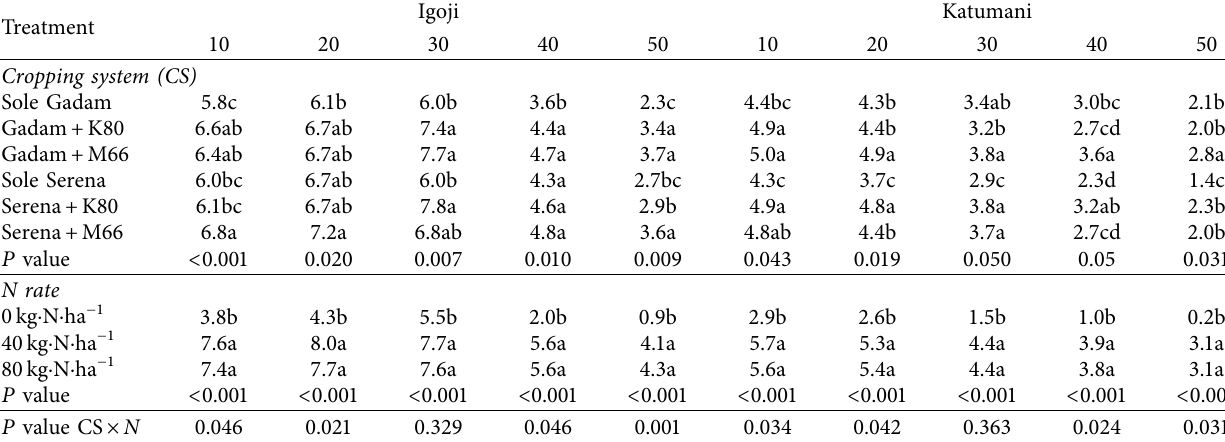
Table 4: Number of green leaves at 10, 20, 30, 40, and 50 days after flowering (DAF) of two sorghum varieties (Gadam and Serena) grown in sole and intercrop system with two varieties of cowpea (K80 and M66) and three N rates at the KALRO, Igoji, and Katumani research station during 2018/2019 short rains